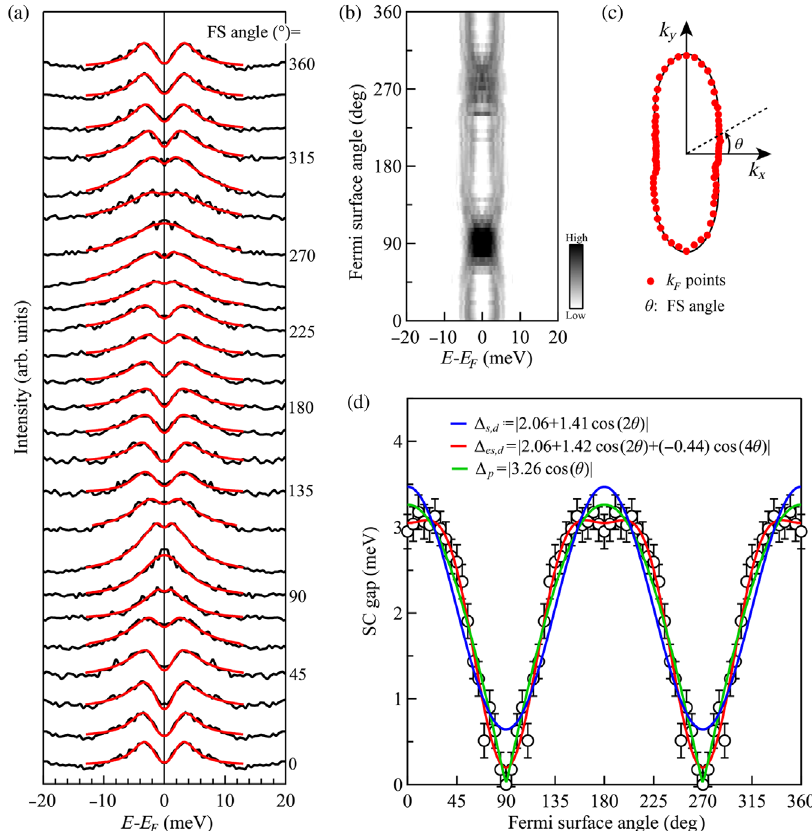
FIG. 2. Momentum dependence of the superconducting gap for FeSe measured at 1.6 K. (a) Symmetrized EDCs at different Fermi momenta along the Fermi surface measured at 1.6 K. These curves are fitted with a phenomenological gap formula (red curves). The same data are plotted in (b) as a false-color image where the variation of the superconducting peak position can be directly visualized. The location of the Femi momentum is defined by the Fermi surface (FS) angle θ as shown in (c). (d) Momentum dependence of the superconducting gap derived from fitting the symmetrized EDCs in (a). To enhance the data statistics and keep the twofold symmetry, the gap value is obtained by averaging over the four quadrants. The measured gap (empty circles) is fitted by s þ d (blue curve), extended s þ d (red curve), and p -wave (green curve) pairing gap